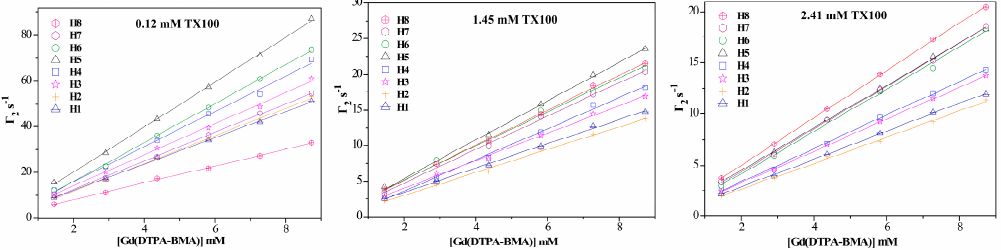
Figure 2. 1 H sPREs of TX100 as a function of the concentration of